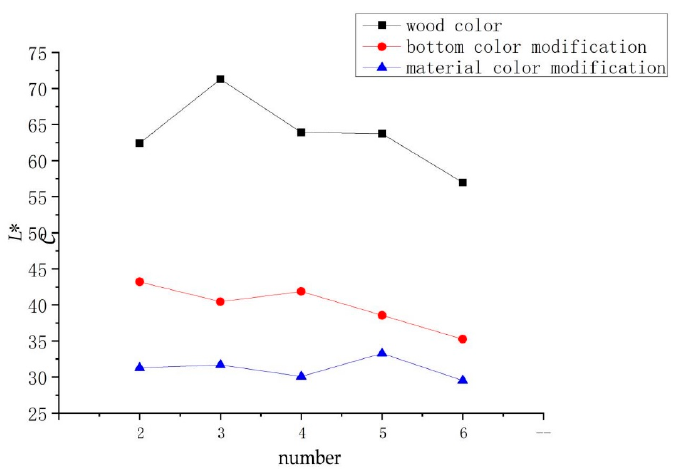
Figure 5. The effect of different surface dispositions to L *.